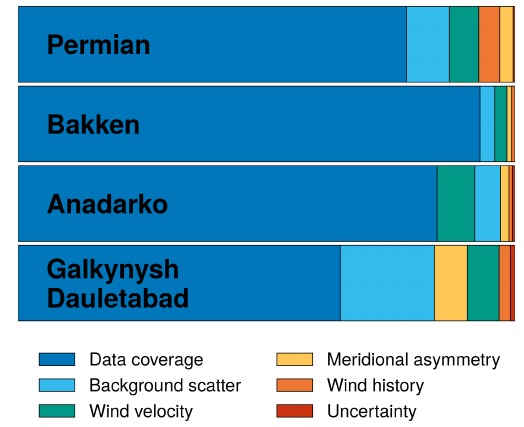
Figure 12. Relative contributions of the selection criteria sorted by importance for different regions. See main text for